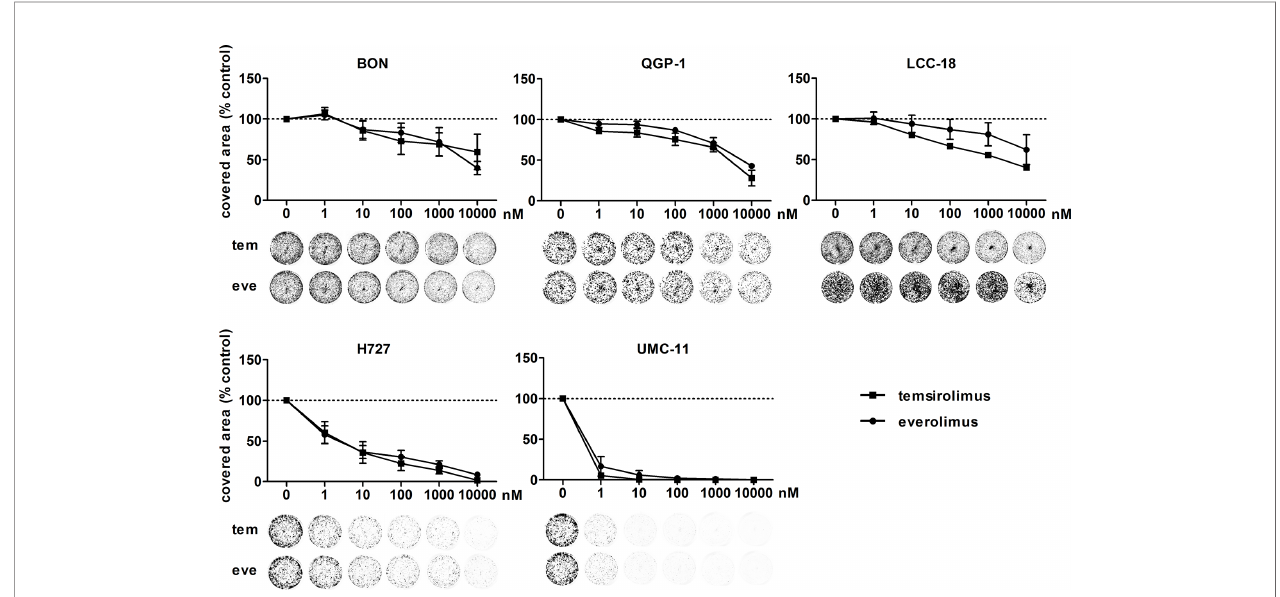
FIGURE 2 | Clonogenic survival of NEN cell lines is affected by mTOR inhibitors. NEN cell lines were seeded at low density, treated with increasing concentrations of temsirolimus (tem) or everolimus (eve) and incubated for 1 – 2 weeks until colony formation. Data were normalized to untreated controls and represent mean ± S.E.M. (n=3-4) or mean only (LCC-18 treated with temsirolimus,